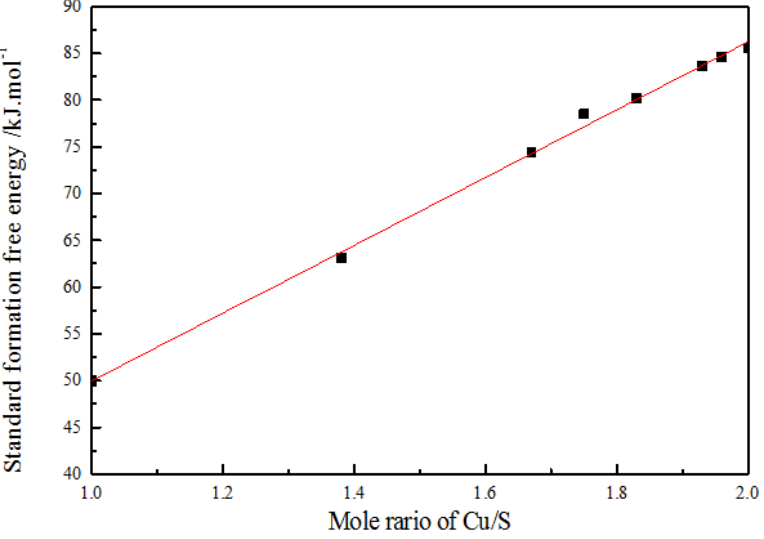
Figure 2. Relation between standard formation free energy and ratio of Cu/S.